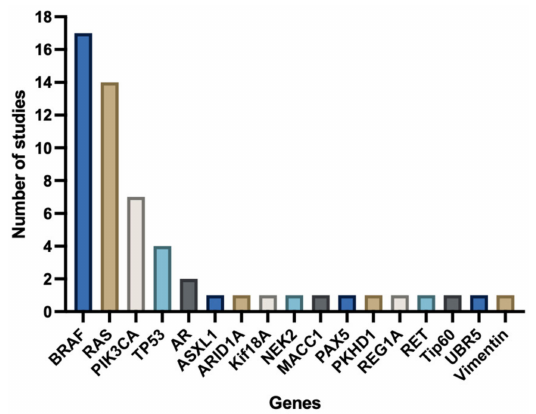
Figure 4. Number of studies investigating specific